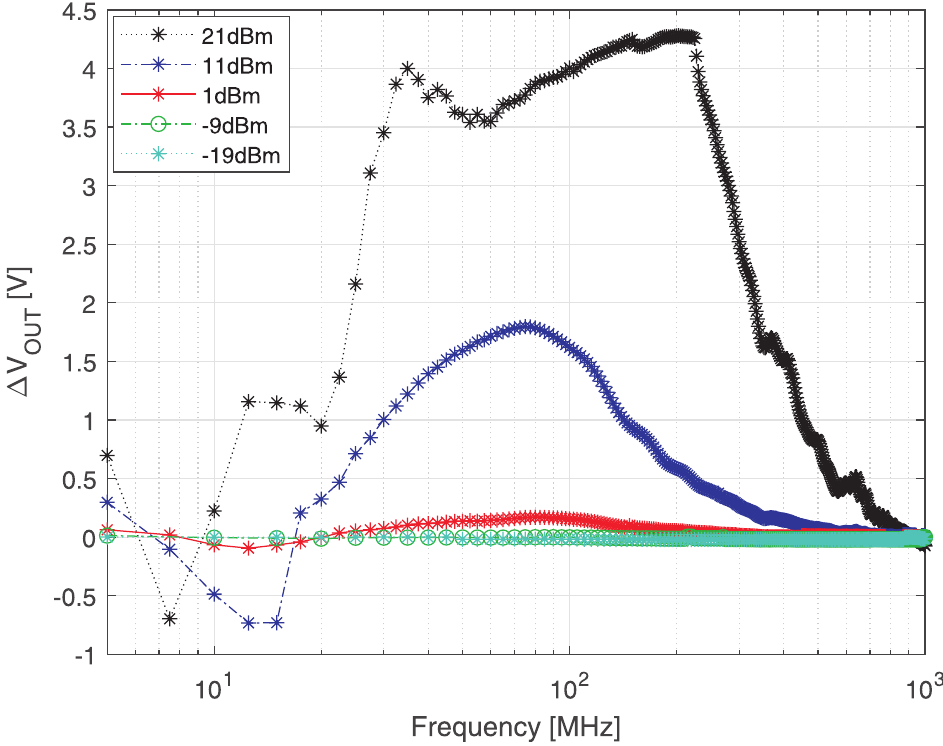
Figure 15. DPI on VDD immunity measurements ( | ∆ V OUT | vs. frequency) for different RF power amplitudes.